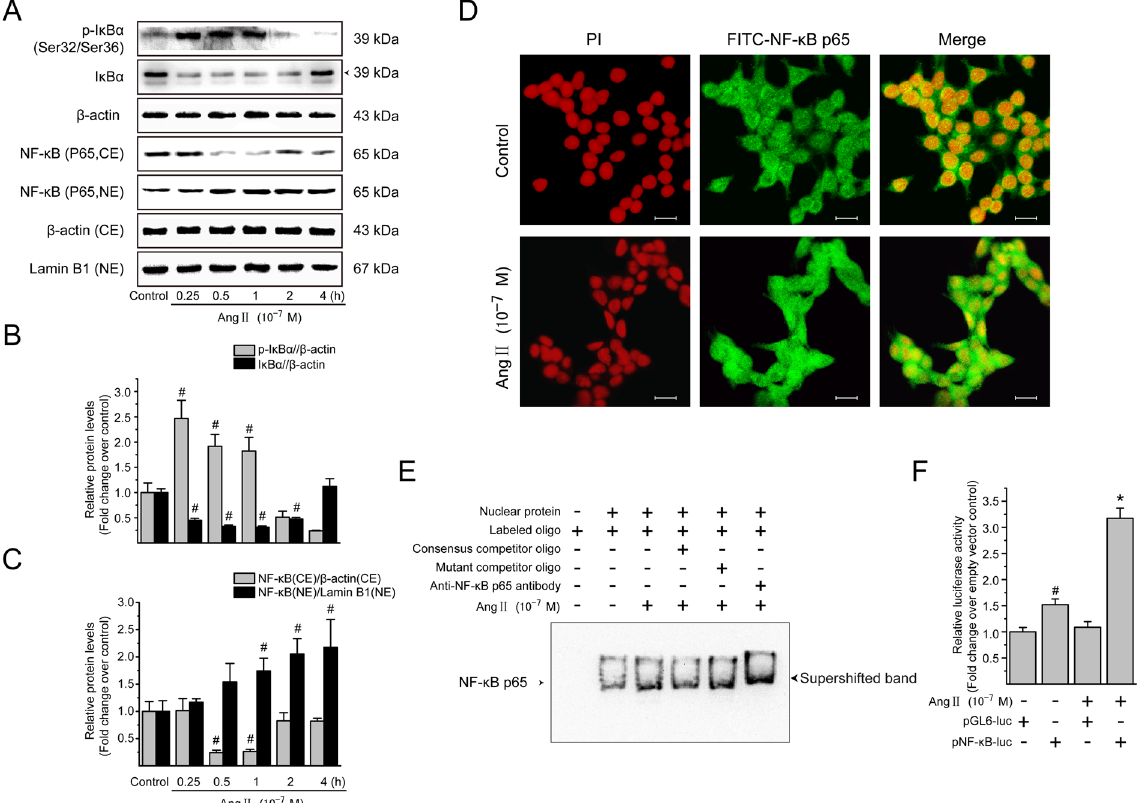
Figure 5. Ang II activates the NF- κ B pathway in LX-2 cells. ( A ) Serum-starved LX-2 cells were treated with Ang II (10 − 7 M) for 0, 0.25, 0.5, 1, 2 and 4 h. Whole cell lysates were immunoblotted with antibodies against I κ B α and its phosphorylated form. β -Actin was used as an internal control. Cytosolic and nuclear extracts were analyzed by immunoblotting for detection of NF- κ B p65. The β -actin and lamin B1 protein levels served as internal controls, respectively, for cytoplasmic extracts (CE) and nuclear extracts (NE). ( B ) The protein levels of phosphorylated I κ B α and I κ B α in whole cell lysates, and ( C ) that of NF- κ B p65 in cytoplasmic and nuclear extracts, were converted to arbitrary densitometric units, normalized by the value of the corresponding internal control and expressed according to the levels in unstimulated cells (defined as 1-fold). ( D ) Immunofluorescence staining was carried out with primary NF- κ B p65 antibody followed by incubation of a FITC-labeled secondary antibody (green). The nuclei were stained with PI (red). In the merged micrographs, the yellow color indicates nuclear localization signal of NF- κ B p65 subunit. Scale bar, 20 μ m. ( E ) Serum-starved LX-2 cells were stimulated in the absence or presence of Ang II (10 − 7 M) for 0.5 h. Nuclear extracts were prepared and the binding activity of NF- κ B with the consensus binding sequences was analyzed by EMSA, as described in Materials and Methods. The DNA-protein interaction was resolved on a 6% native polyacrylamide gel and the biotin-labeled DNA bands were visualized by an ECL assay Kit. ( F ) Serum-starved LX-2 cells were transfected with either firefly luciferase reporter of NF- κ B (pNF- κ B-luc) or pGL6-luc reporter construct followed by incubation with Ang II (10 − 7 M) for 0.5 h. The Renilla luciferase reporter was also co-transfected into the cells for normalizing transfection efficiency. The luciferase activity in the cellular extracts was evaluated by the Dual- Luciferase Reporter Assay System and normalized to the activity of Renilla . Experiments were repeated 3 times with similar results, and all data are presented as mean ± SD. # P < 0.05 versus unstimulated or pGL6-luc empty vector-transfected control cells; * P < 0.05 versus pNF- κ B-luc-transfected cells without Ang II